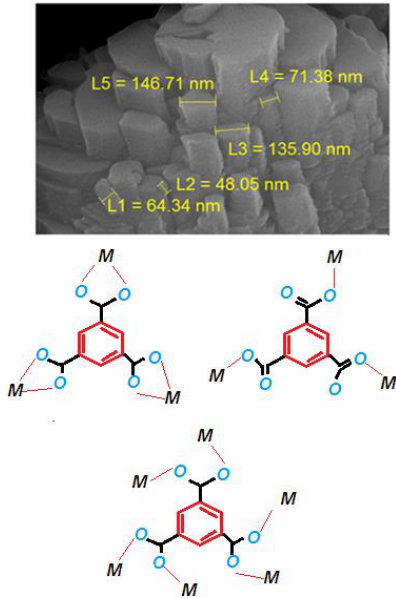
Fig.5 SEM image and X-ray pattern of synthesized MOF sample (inset) The possible configurations of 1,3,5-benzenetricarboxylic acid with metal